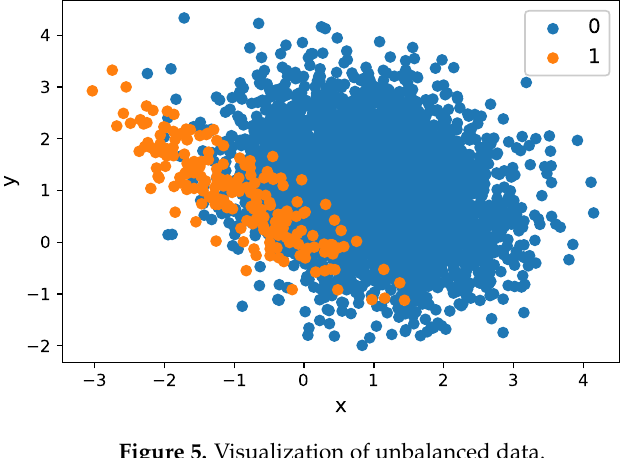
Figure 5. Visualization of unbalanced data.